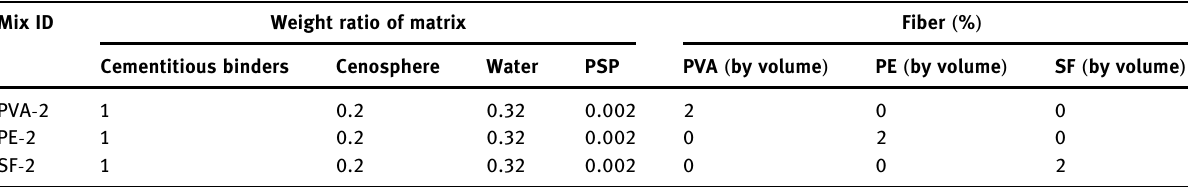
Table 2: Proportions of the mixtures